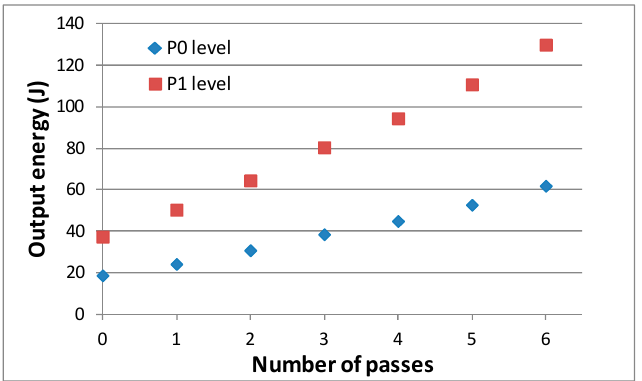
Figure 4. Calculated pulse energy evolution during the propagation in AMP3 at the level of performance of P0 and P1. Each pass corresponds to a single transit of the pulse in the disk (a single reflection consists of 2 passes).